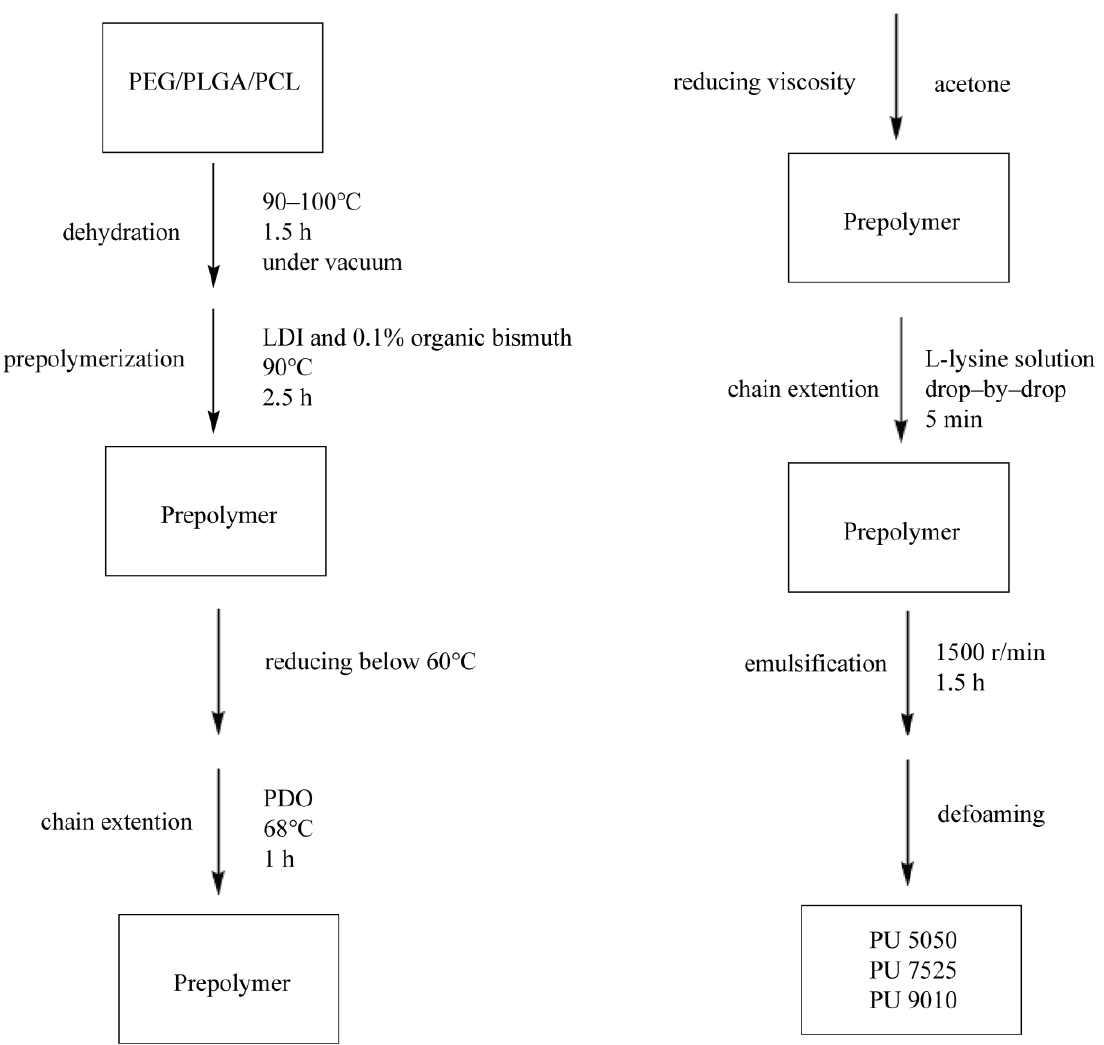
Table 1. The molar composition of WPUs (R value (-NCO/(-OH+-NH 2 )) is 1.4). Soft